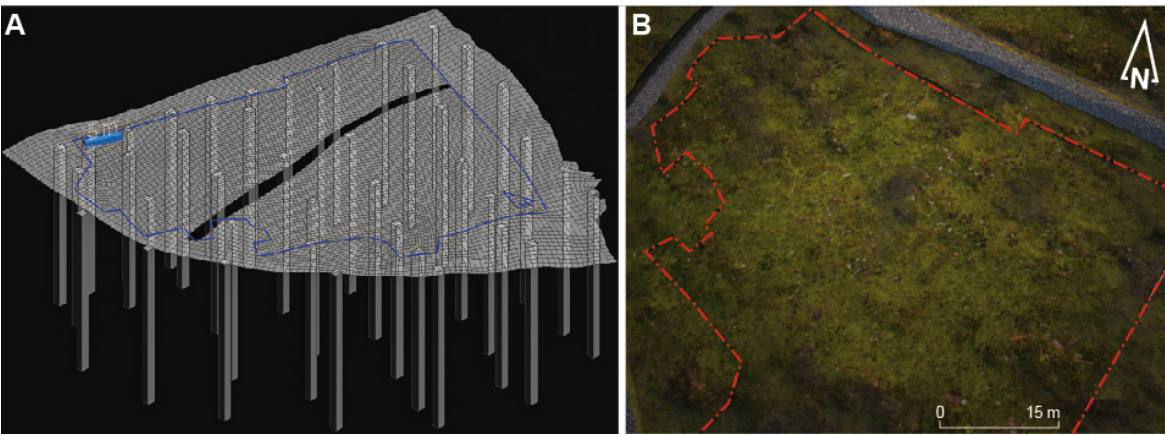
Figure 5. ( A ) Creating the surface DTM from Geoportail data; ( B ) rendering a 3D topographical framework of the site prior to the excavation.